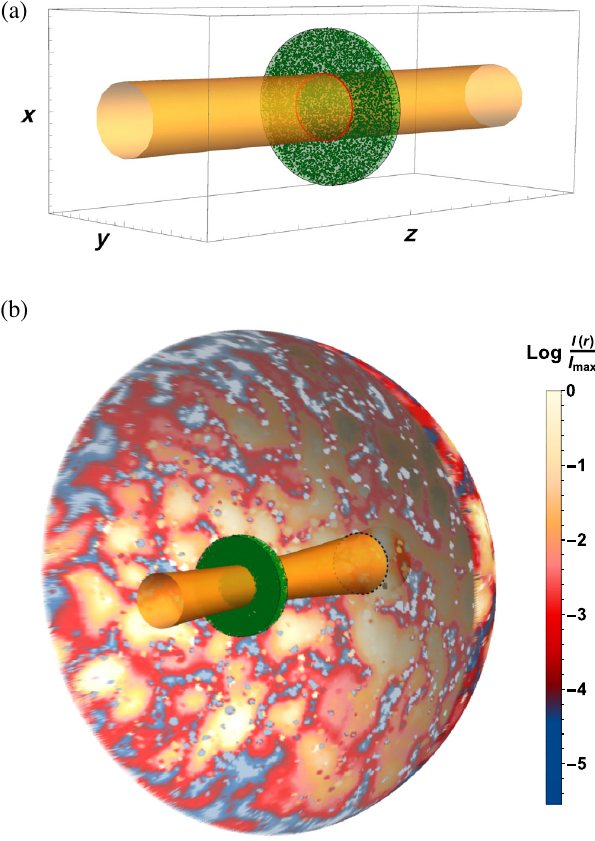
FIG. 2. Simulated physical system. (a) Cylindrical ensemble ffiffiffiffiffiffiffiffiffiffiffiffiffiffiffiffiffiffiffiffiffiffiffi p of randomly distributed atoms (green points) illuminated by a 1 þ ð z=z describes the Þ 2 z-directed Gaussian beam, whose beam waist w ð z Þ ≫ λ 0 is R represented in orange. The transverse radius of the cylinder is chosen to be much larger than the beam waist to avoid edge diffraction. (b) Color-coded 3D representation of the forward scattered intensity I ð r ; ω 0 Þ ¼ j E ð r ; ω 0 Þj 2 = ð 2 μ 0 c Þ (with the value indicated in the color bar) over a hemispherical surface far from the ensemble (the radius of this hemisphere is 35 λ 0 ), given an incident resonant Gaussian beam. The intensity is calculated for a single random atomic configuration. The system parameters used are as follows: beam waist w 0 ¼ 3 λ 0 , cylinder radius l and thickness d ¼ 2 λ 0